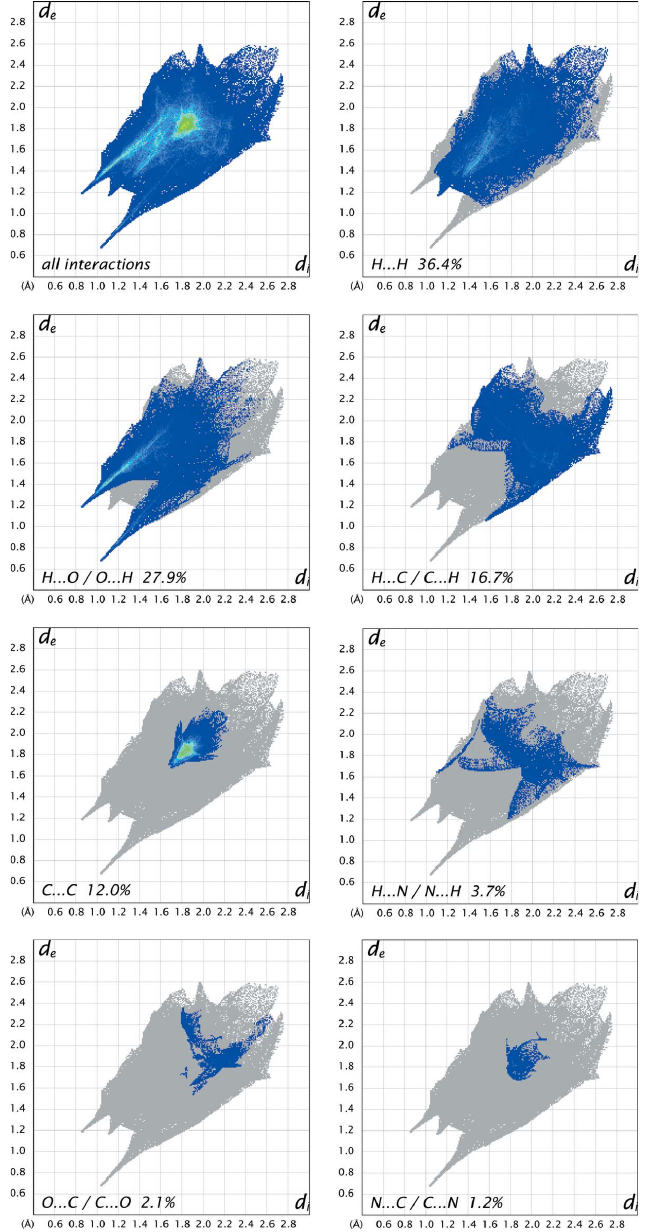
Figure 7 The full two-dimensional fingerprint plots for the cationic-complex subunit, showing all interactions and split up into contributions from different contacts. The d i and d e values are the closest internal and external distances (in A˚ ) from given points on the Hirshfeld surface